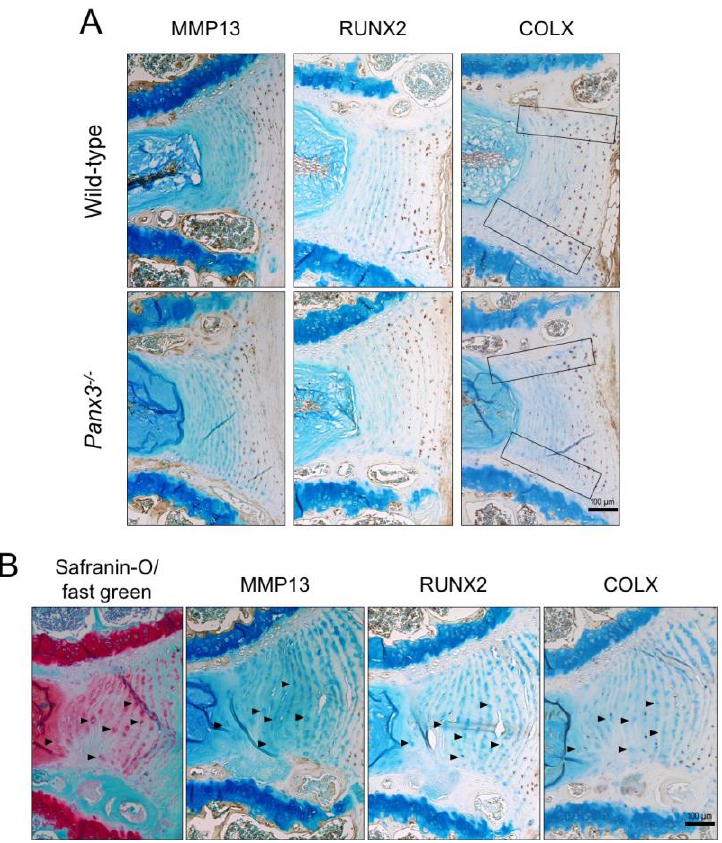
Figure 4 . Localization of hypertrophic chondrocyte markers in Panx3 -/- IVDs. ( A ) Representative mid-sagittal sections of lumbar IVDs from 19-month-old WT and Panx3 -/- mice immunostained for either MMP13, RUNX2 or COLX (indicated by brown stain). Sections were counterstained with methyl green. Black boxes highlight the CEP-AF interface (n = 5 mice per group, 4–6 IVDs per mouse). ( B ) Serial sections of a representative WT lumbar IVD at 19 months-of-age stained with either safranin-O/fast green (red stain indicative of proteoglycan content) or anti- MMP13, RUNX2 or COLX antibody (indicated by brown stain) counterstained with methyl green. Arrowheads indicate enlarged AF cells.